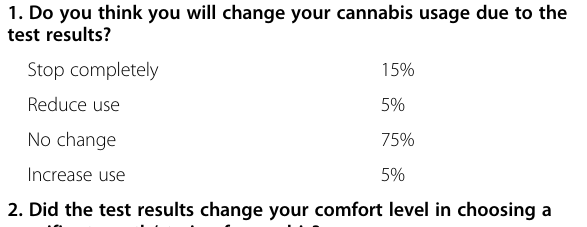
Table 2 Attitudes towards pharmacogenetic testing among 20 medical cannabis patients in Toronto,